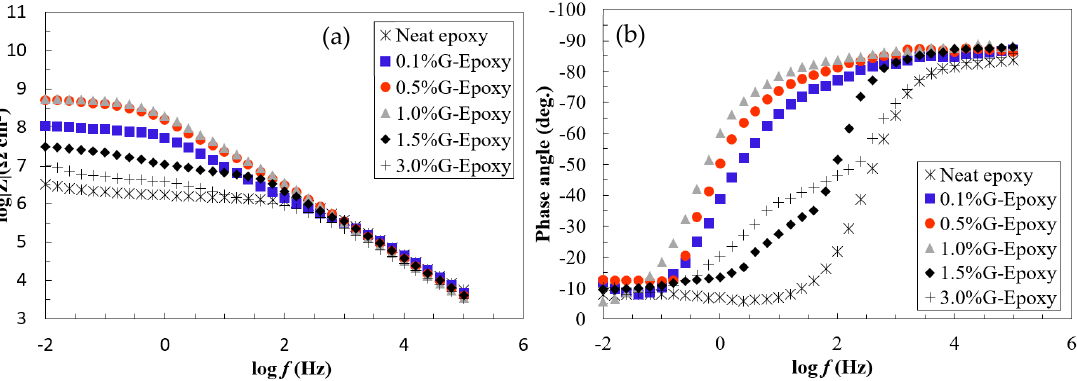
Figure 8. Bode plots of ( a ) impedance and ( b ) phase angle for the test samples after 200 h exposure.